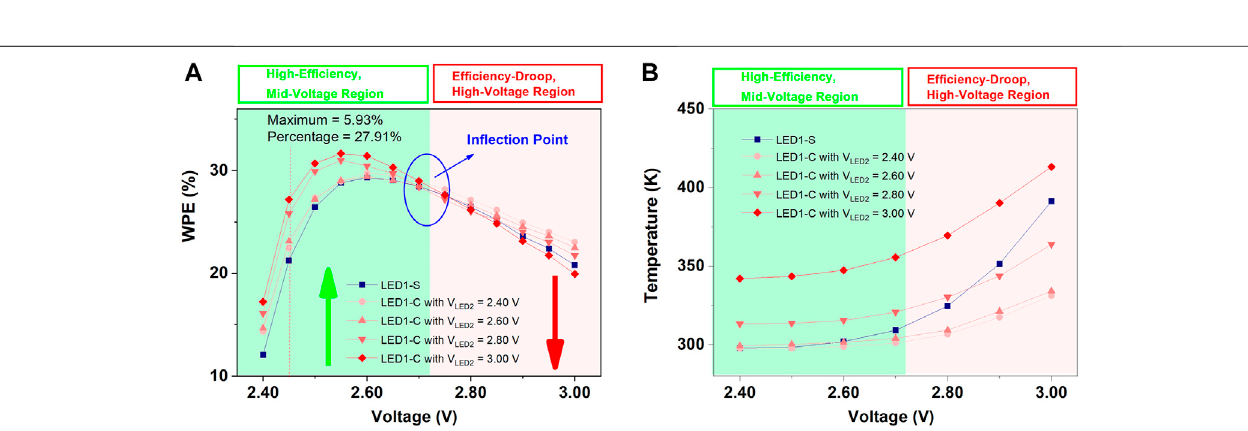
FIGURE6|(A) TheWPEand (B) devicetemperatureofLED-1asafunctionofappliedvoltagefortheSeparated-LEDsandCombined-LEDssetupsunderV LED-2 (cid:2) 2.40, 2.60, 2.80, and 3.00 V.